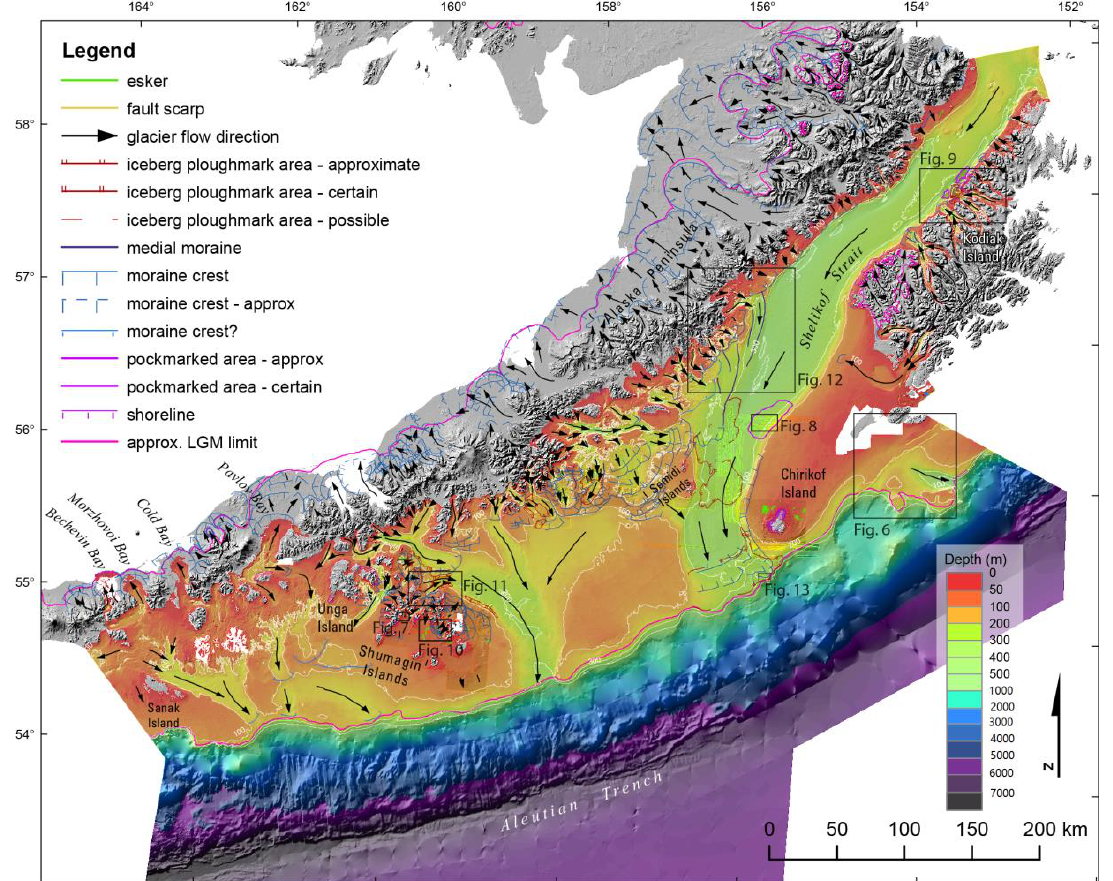
Figure 5. Geomorphic map of the Alaska Peninsula region. See text for discussion of features mapped. White lines show 100, 200, and 300 m depth contours. Last Glacial Maximum (LGM) extent shown on the north side of the Alaska Peninsula is from Kaufman et al. [46]. LGM limit on the south side of the Alaska Peninsula is from this study. Location of Figures 6 – 13 indicated. Geographic information system (GIS) data and larger version of map in Supplementary Information.